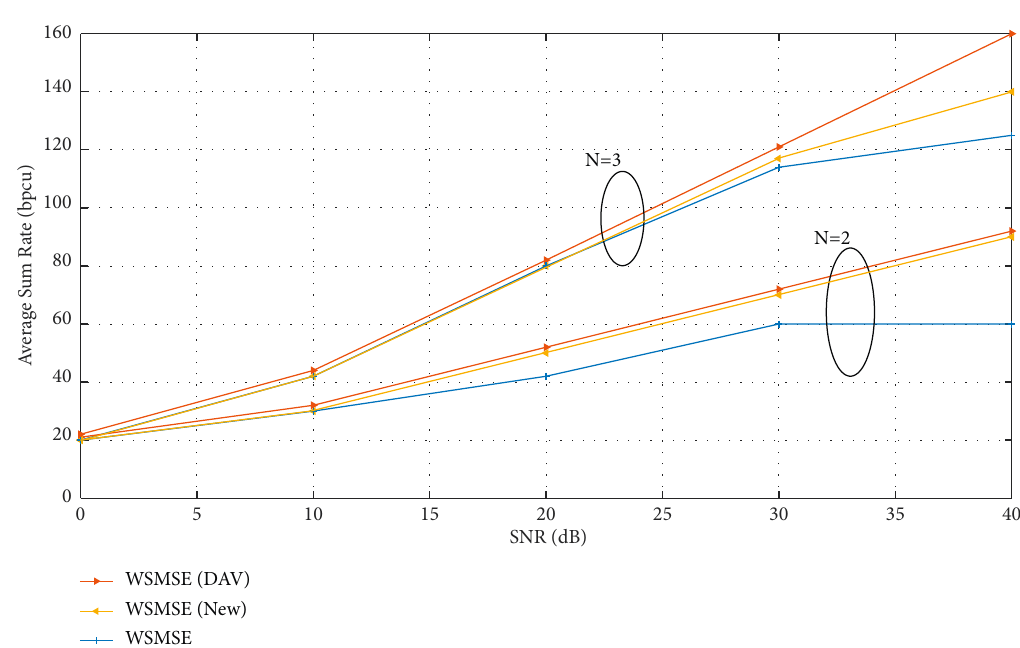
Figure 5: WSR in terms of SNR for C � 5, K � 8, M � 15, and N � {2,